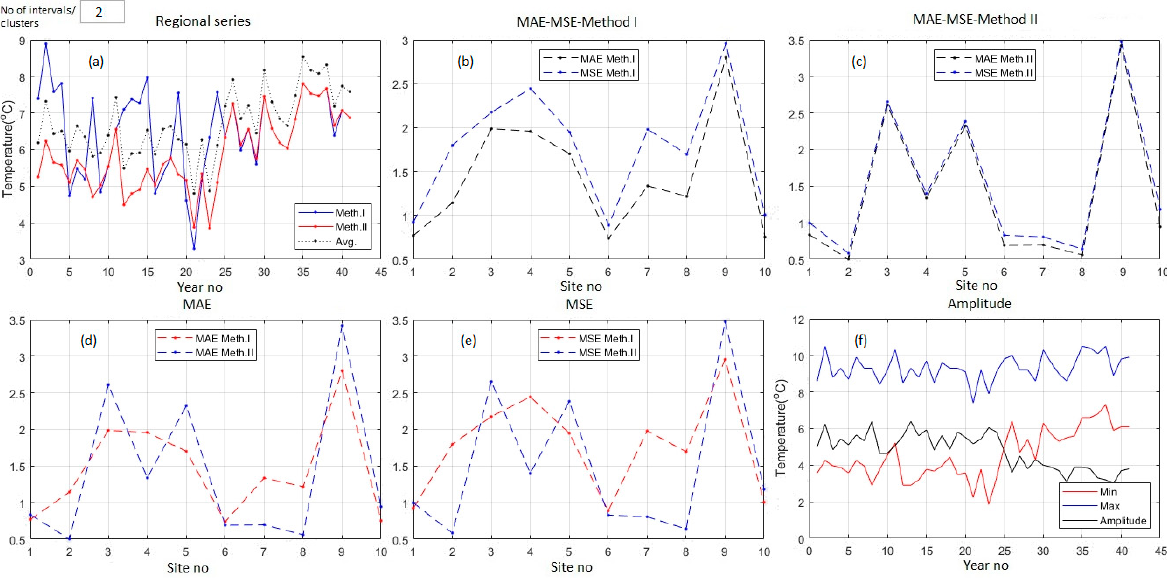
Figure 4. The case of two intervals/clusters for the series of minimum temperatures: ( a ) ‘Regional series’; ( b ) MAE and MSE—Method I; ( c ) MAE and MSE—Method II; ( d ) comparisons of MAEs; ( e ) comparisons of MSEs; ( f ) min, max, and amplitude of the minimum temperature series.